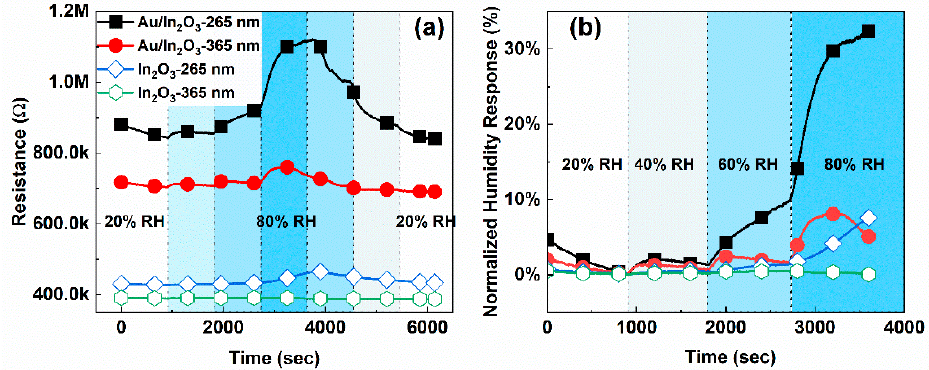
Figure 5. ( a ) Transient response of the various sensors to humidity change. ( b ) Normalized response from 20% RH to 80% RH.